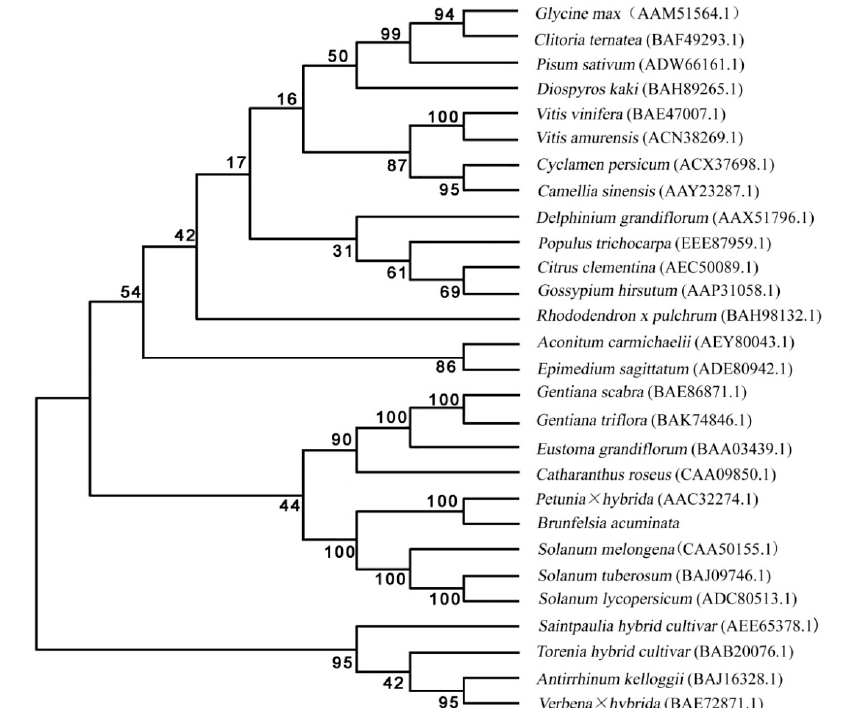
Figure 7. A Phylogenetic tree of deduced amino acid sequences of F3 ′ 5 ′ H. The phylogenetic tree is a neighbor-joining tree calculated by Poisson model, and the bootstrap values (in %) are from 1000 replications.